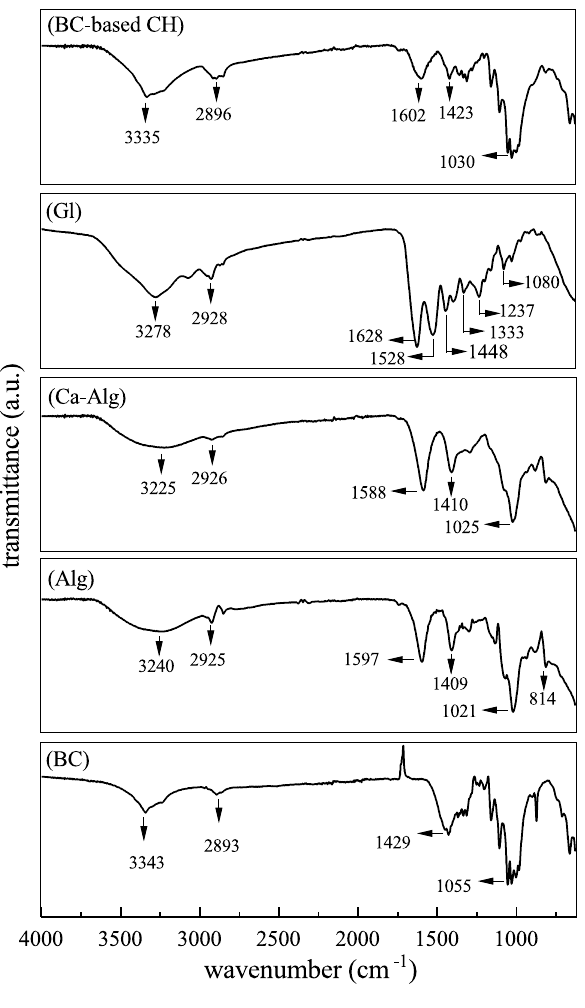
Figure 1. FTIR spectra of the samples of each biopolymer used in the present study before being combined to prepare the composite hydrogel (BC-based